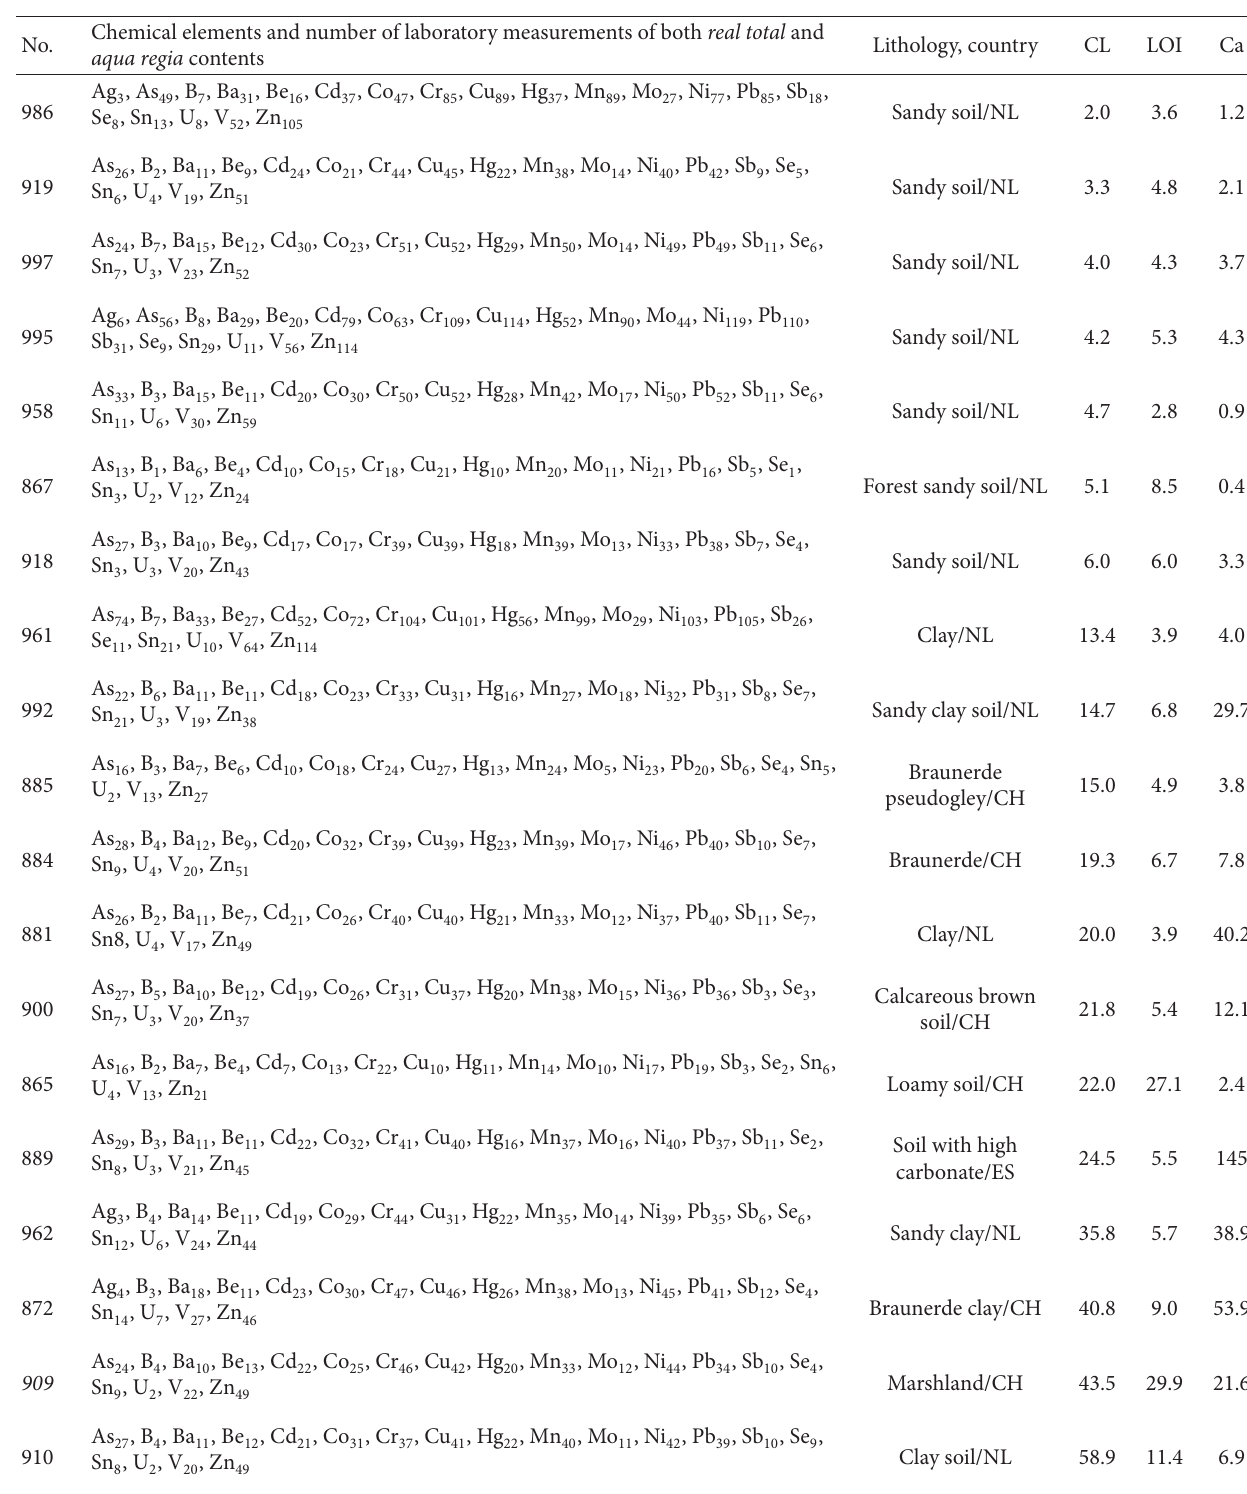
T 1: Characteristics of